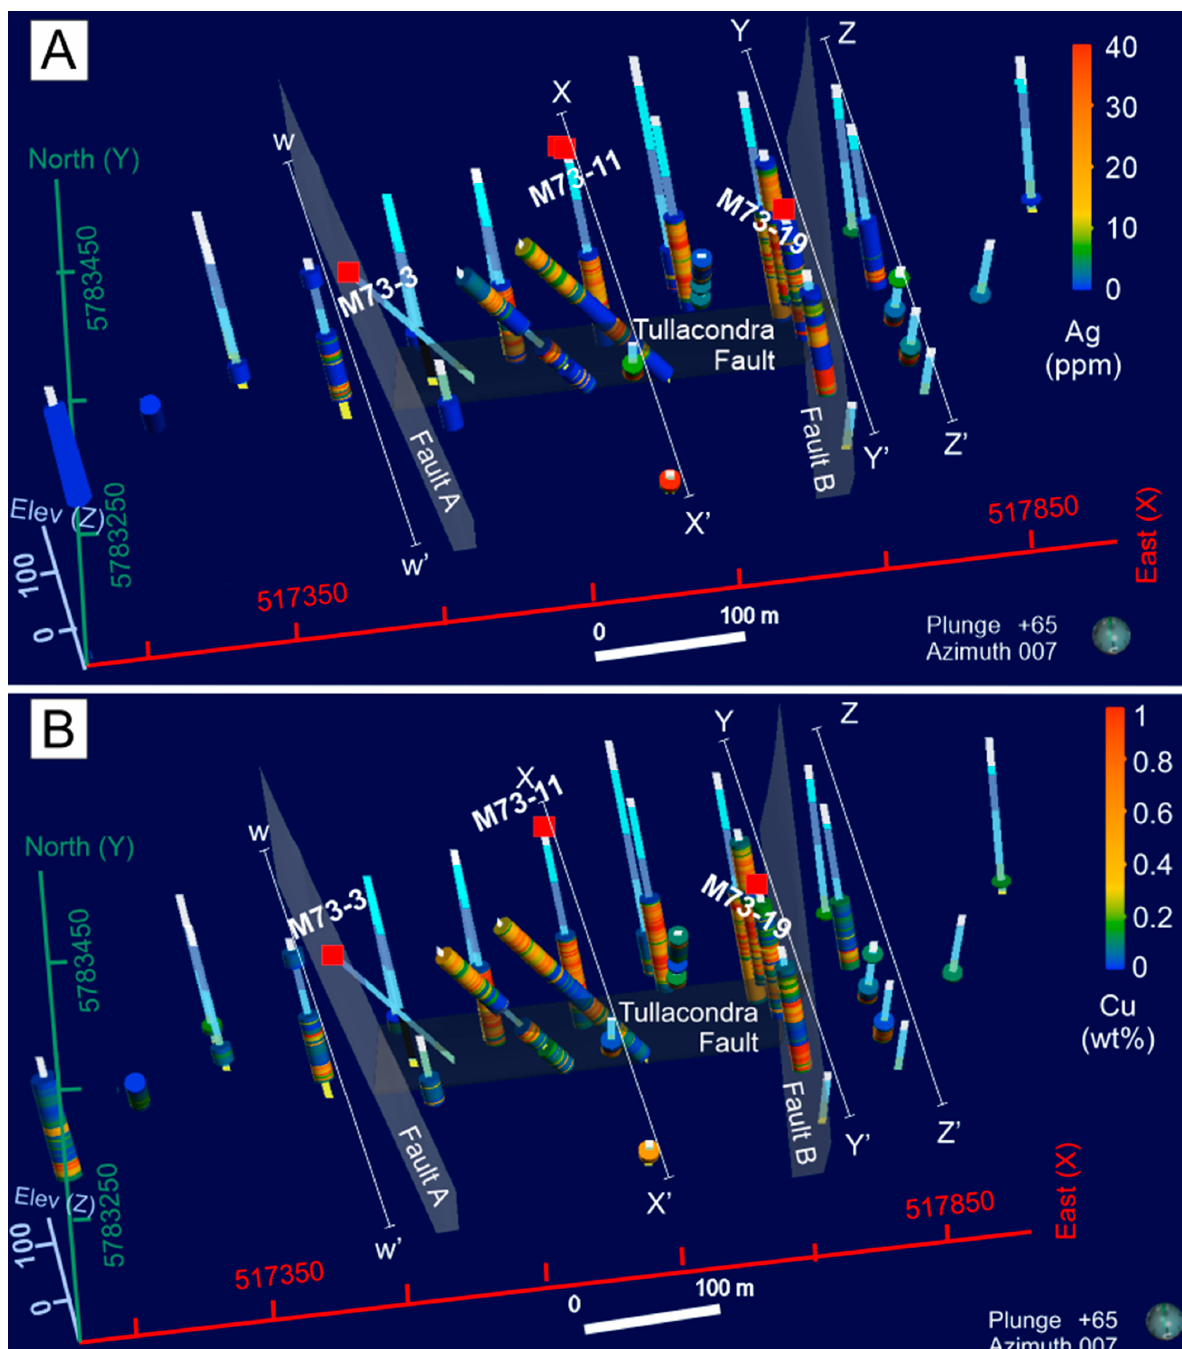
Figure 3. Local geological map of the Tullacondra deposit based on legacy data from drill hole logs and its main structural features (the Tullacondra, A, and B faults). The ore shell is represented in gray and corresponds to the mineralized zones with Cu > 0.2% and Ag >14 ppm to reflect natural breaks in grade values. Note the dolomitized area is roughly coincident with Fault